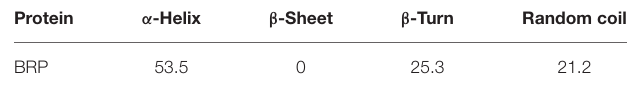
TABLE 2 | Secondary structure contents (%) of BRP. Protein α -Helix β -Sheet β -Turn Random coil BRP 53.5